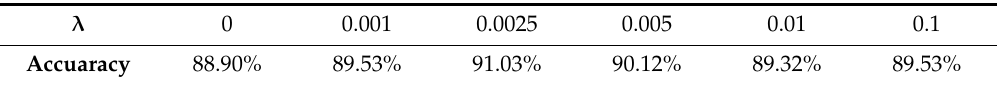
Table 4. Classification accuracies of the proposed joint loss with di ff erent λ (CNN: ResNet50) ( λ = 0.00 corresponds to the conventional cross-entropy